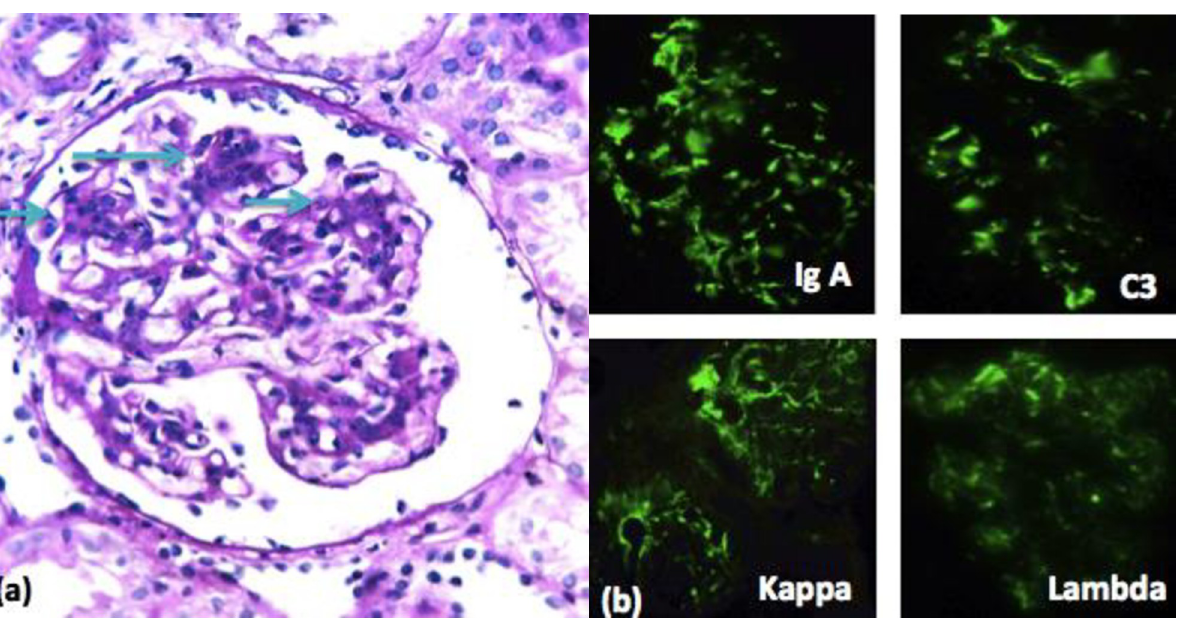
Fig 9. a. Ig A nephropathy with increased mesangial matrix and cellularity (arrows) (PAS stain x400). b DIF shows strong positivity with Ig A, C3, kappa and lambda.